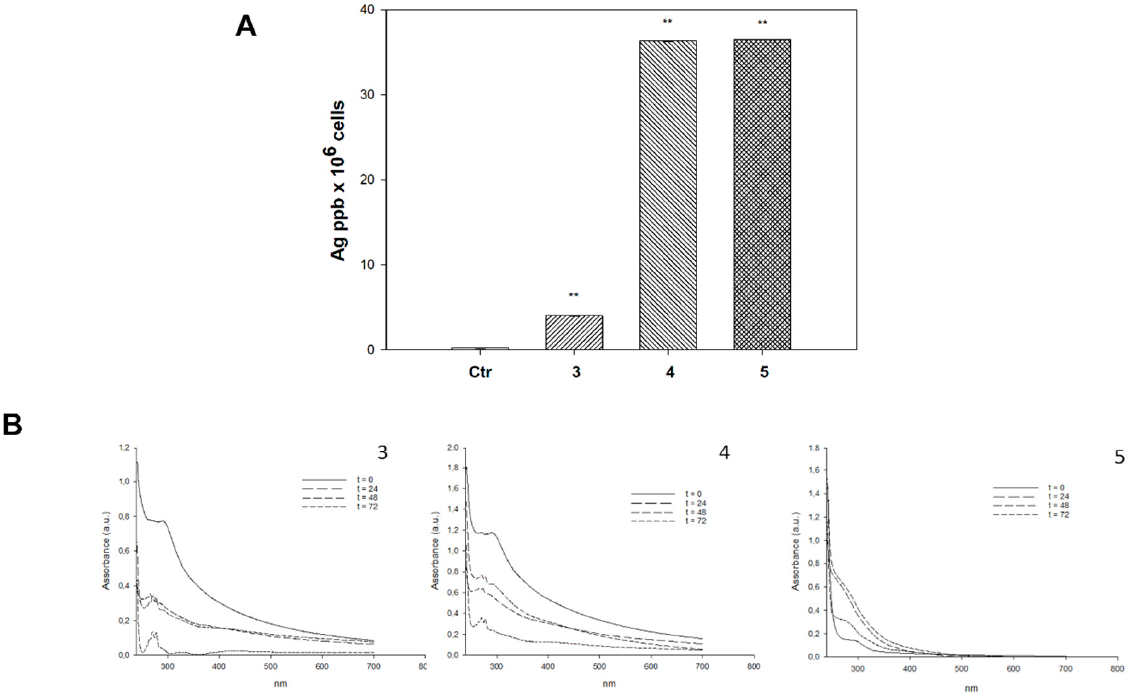
Figure 1. Cellular uptake and stability studies. ( A ) Intracellular accumulation of silver(I) complexes 3–5 . U1285 cells were incubated with 2 µM of silver(I) complexes for 24 h, and cellular silver content was detected by GF-AAS analysis. Error bars indicate the standard deviation. ** p < 0.01 compared with control. ( B ) Stability studies. All complexes were dissolved at 50 µM in 0.5% DMSO/RPMI. UV–visible spectra were recorded at t = 0 min, t = 24 h, t = 48 h and t = 72 h.